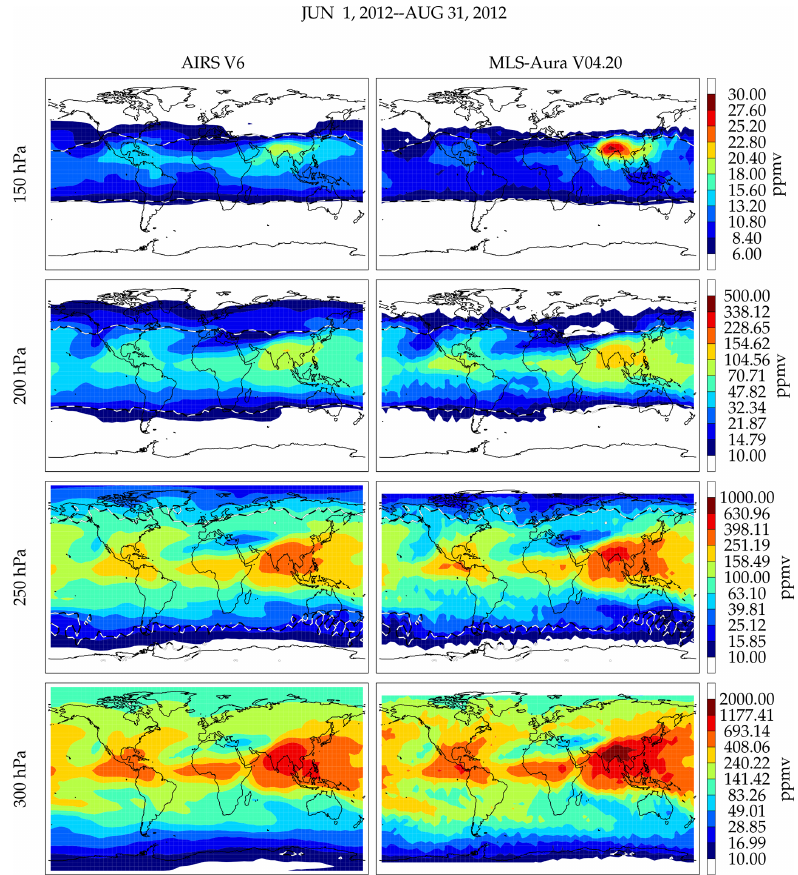
Figure 20. Gridded map comparison between MLS-Aura and AIRS V6 during June–August 2012. The tropopause is indicated by the black and white dashed contour line. Equatorward of this line is in the troposphere and poleward of this line is in the stratosphere. The white regions are H 2 O < 10ppmv. MLS has no measurements poleward of 82 ◦